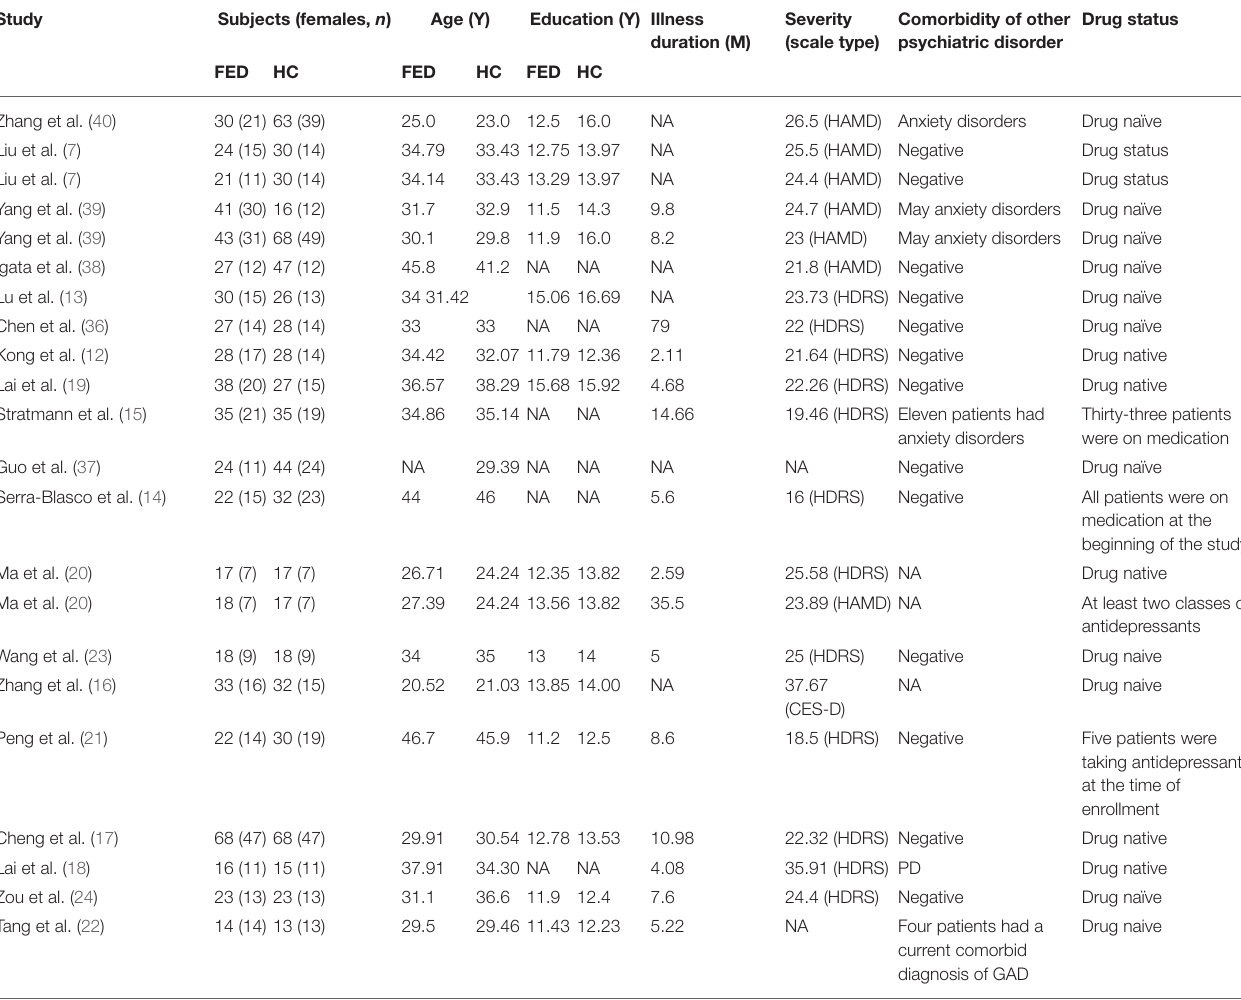
TABLE 1 | Demographic and clinical characteristics of subjects in the 22 voxel-based morphometry datasets included in the meta-analysis a . Study